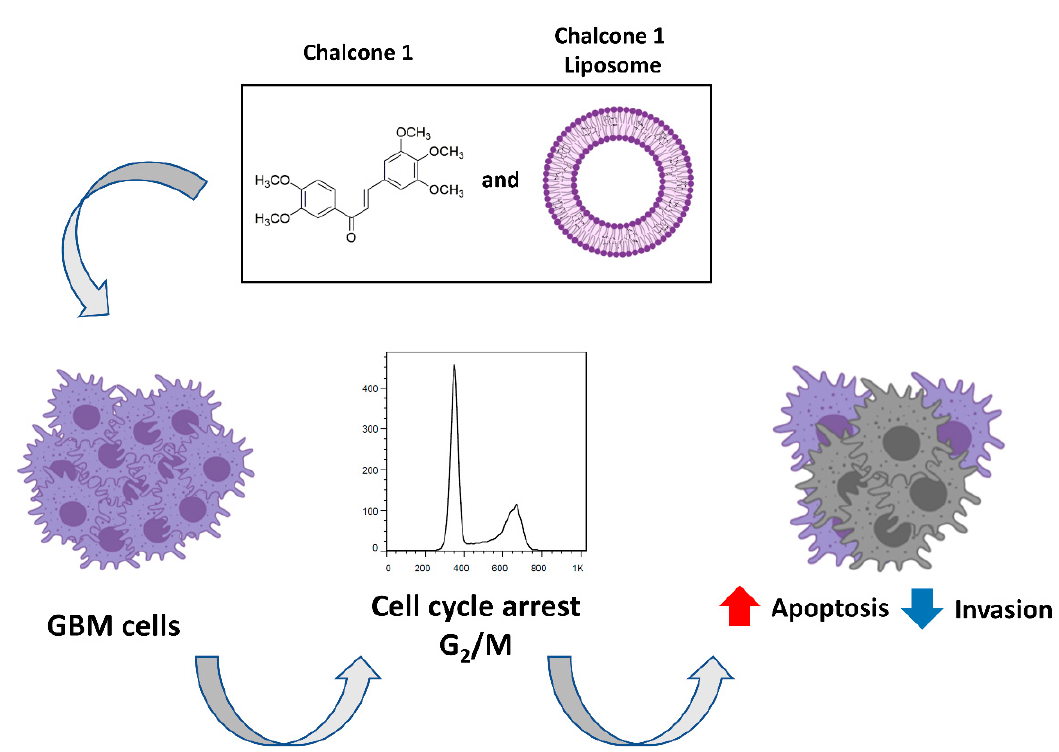
Figure 7. Impact and mechanism of action of chalcone 1 in GBM cell lines.